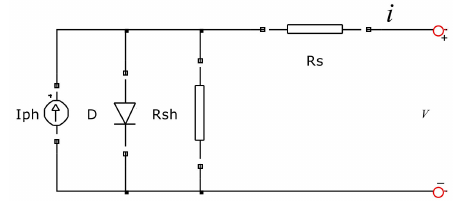
Figure 5. Equivalent circuit of the photovoltaic